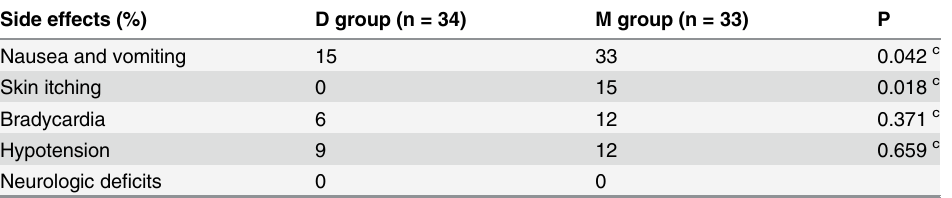
Table 3. The comparison of postoperative side effects observed in both the